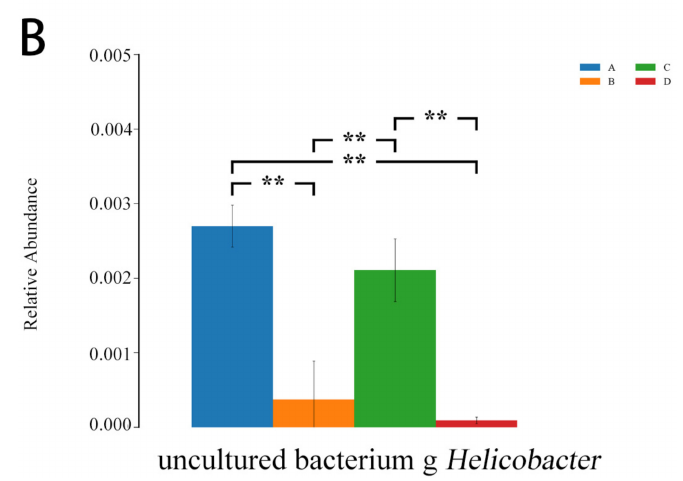
Figure 13. ANOVA analysis diagram. Note: A: CON group, B: L.S group, C: E. coli group, D: L.S + E. coli group. ** indicates extremely significant difference ( p < 0.01). ( A ): the relative abun- dances of Ralstonia ( B ): the relative abundances of Helicobacter